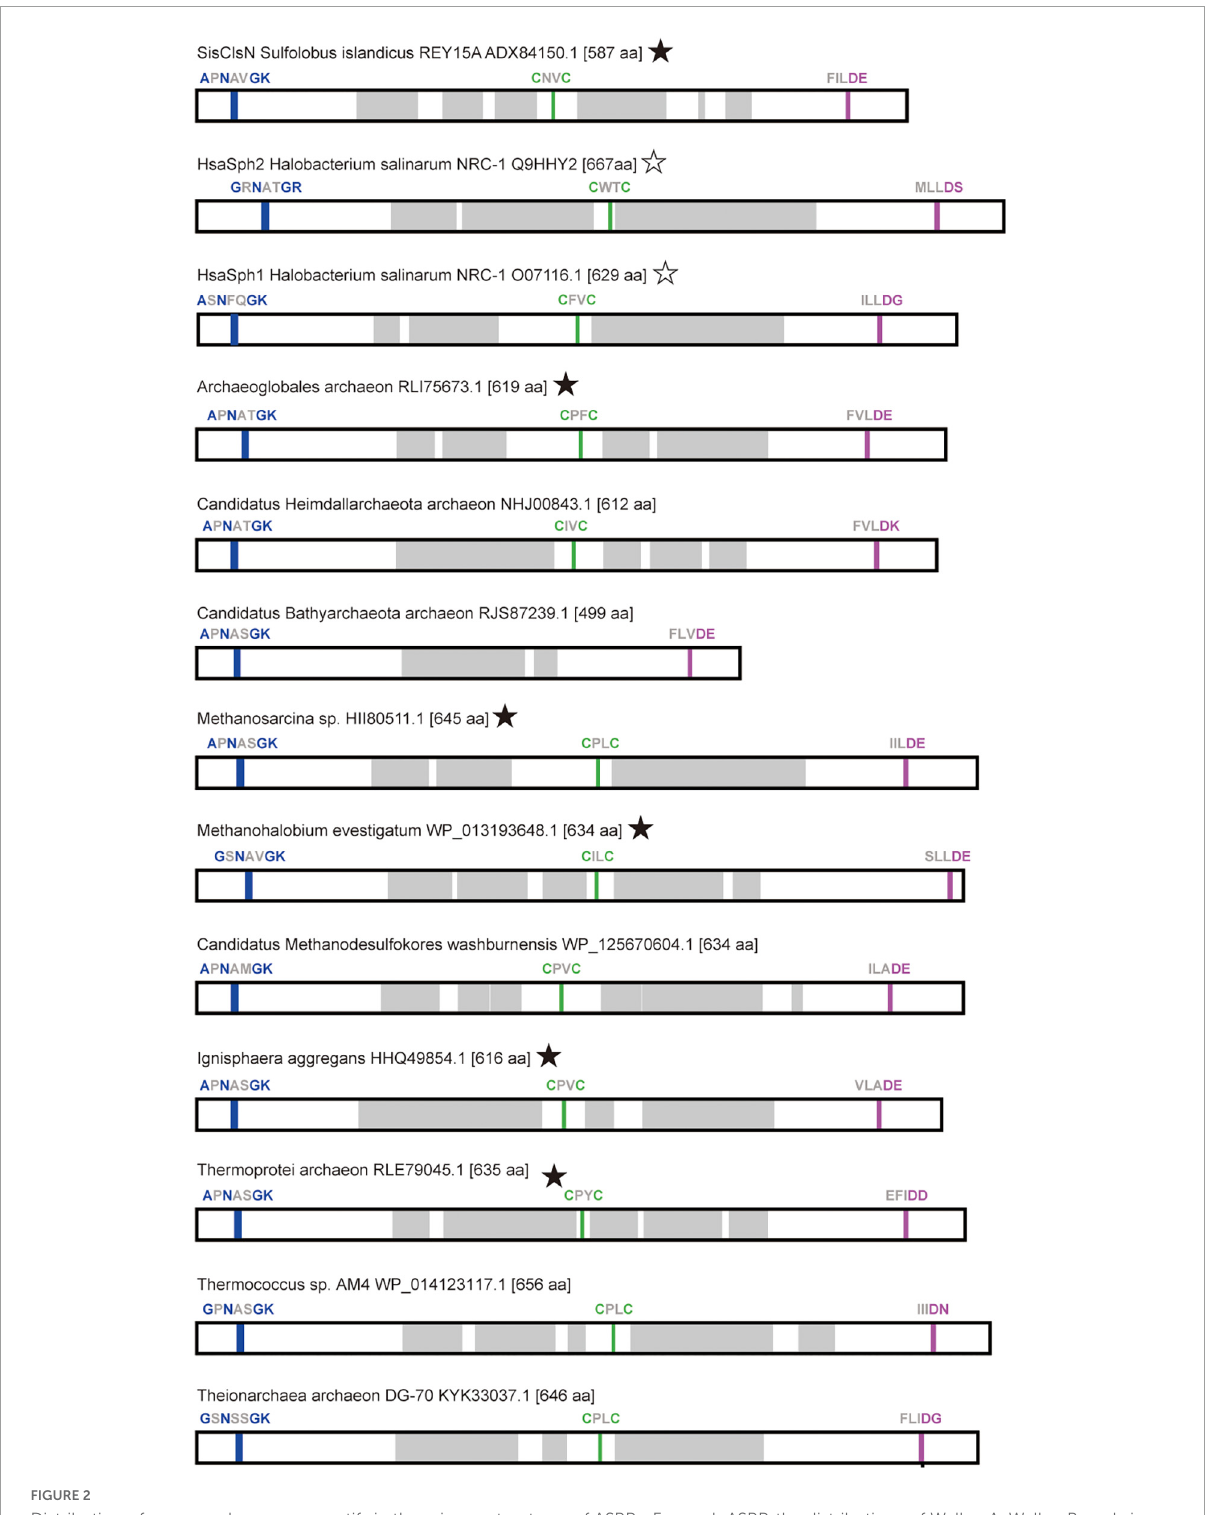
FIGURE2 Distribution of conserved sequence motifs in the primary structures of ASRPs. For each ASRP, the distributions of Walker A, Walker B, and zinc hook motifs are shown in blue, magenta, and green, respectively. The coiled coil regions (shown in gray) were predicted by Waggawagga [http://waggawagga.motorprotein.de/; Simm et al. (2015)]. The ASPR sequences, of which tertiary structures were predicted (see Figure 3 ), are marked by filled stars. We marked Hsa Sph1 and Hsa Sph2 with open stars, as their predicted tertiary structures are available in AlphaFold Protein Structure Database